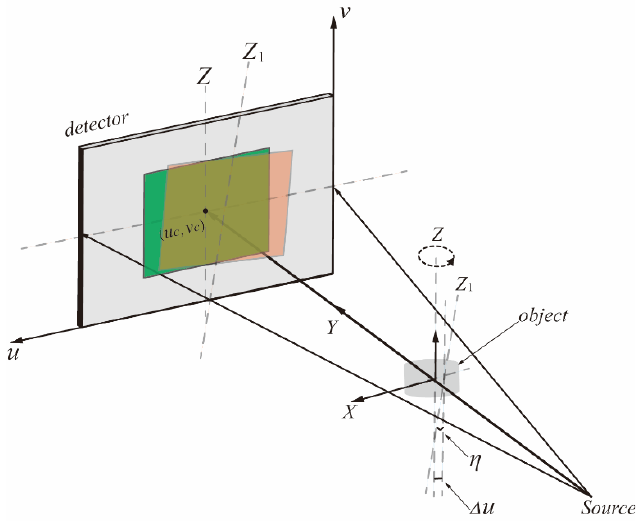
SOD SDD u c v c